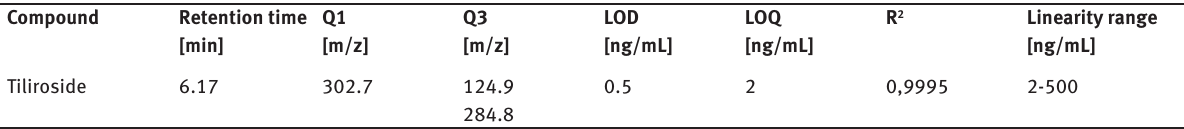
Table 3: Summary of optimized parameters for quantitative LC-ESI-MS/MS analysis of tiliroside. Compound Retention time Tiliroside